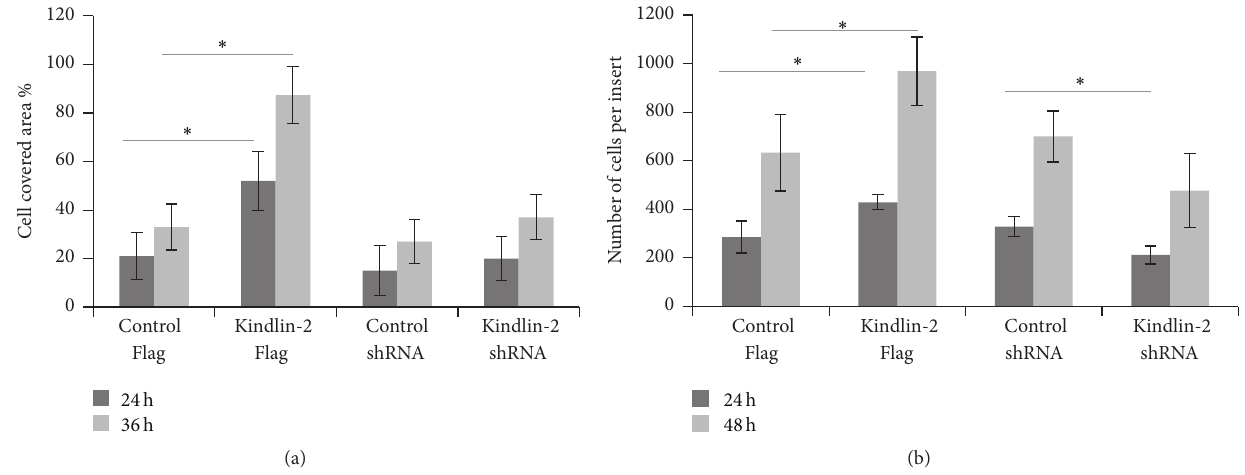
Figure 6: Kindlin-2 affects migration potential of iPSC-MSCs. An in vitro migration assay was performed with an IBIDI culture insert containing two reservoirs separated by a 500 𝜇 m thick wall. Kindlin-2 Flag transfected iPS-MSCs had significantly increased migration potential after 24 h and 36 h compared to control groups (a). Moreover, the migration assay with a transwell system showed significantly increased migrating iPSC-MSCs on the lower face of the filters after 48 h of incubation in Kindlin-2 Flag transfected iPSC-MSCs compared to control Flag (b). The covered area between the two reservoirs was analyzed with ImageJ software. ∗ Significance difference 𝑝 ≤ 0.05 . 𝑛 = 3 .